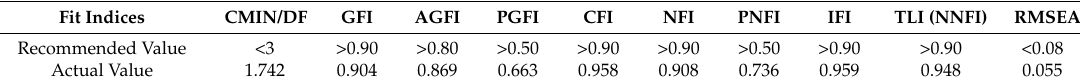
Table 4. Recommended and actual values of fit indices.